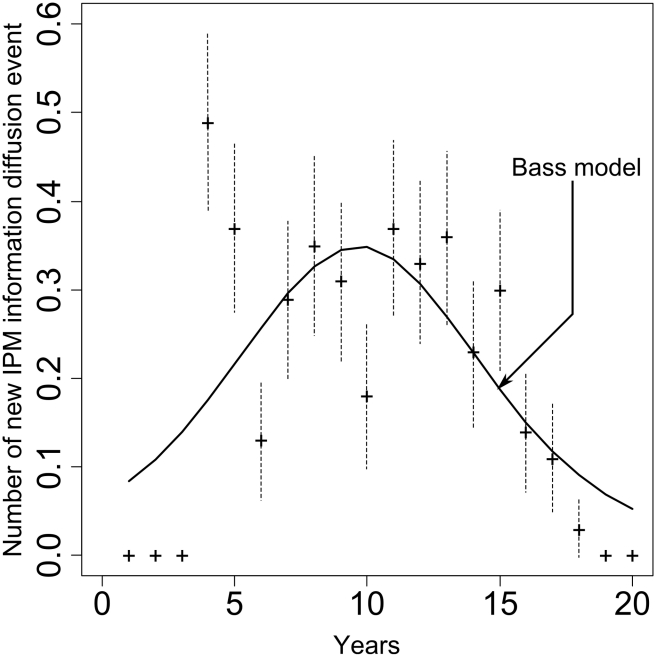
Number of new IPM information diffusion event over time fitted to the Bass model.The fit was obtained following [47] (p = 0.015±0.001, P<0.001; q = 0.296±0.011, for all parameters t≥12.67, P<0.001). Each point is the mean of 100 repetitions with confidence intervals 95% in dashed lines. The theoretical prediction curve represents the derivative of N over time.